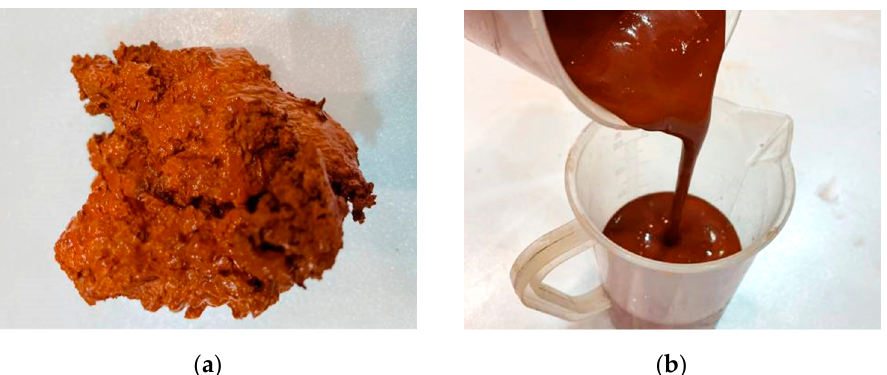
Figure 1. Manufacturing process of LRM: ( a ) RM sludge with a moisture content of 36 wt.%, ( b ) resulting LRM.